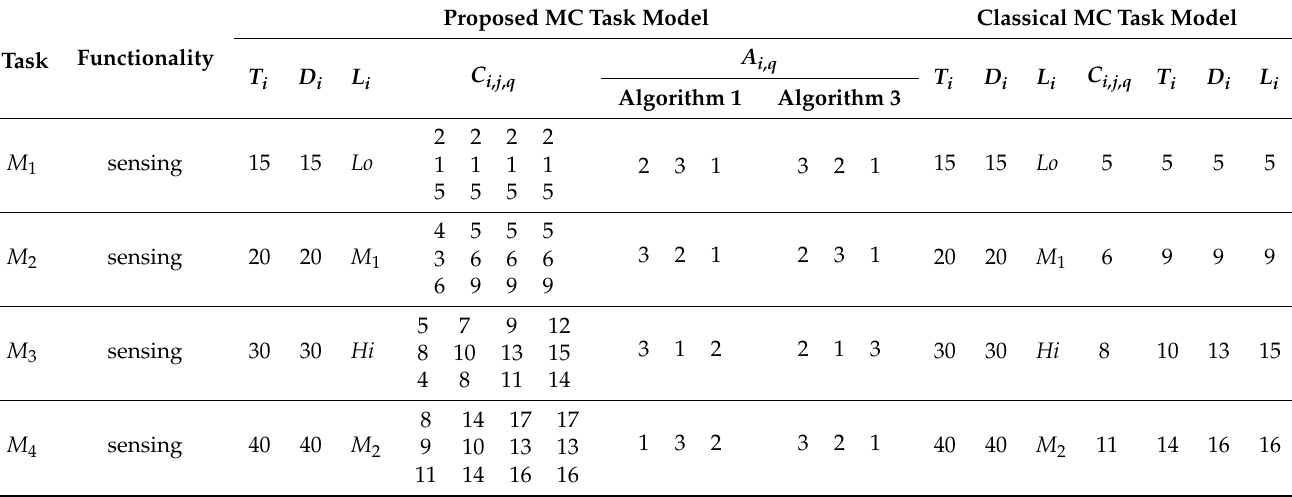
Table 4. Task Model Example 2.